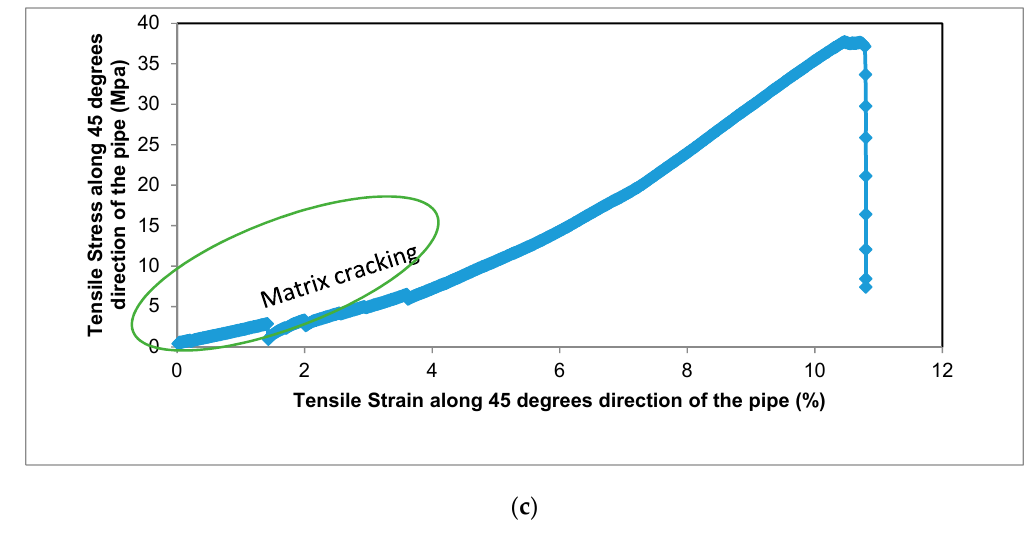
Figure 10. (a) Prepared specimens machined along the 45 ° direction; ( b ) Failed specimen showing matrix cracking and fiber breakage; ( c ) Stress–strain curve of 45 ° direction specimens.